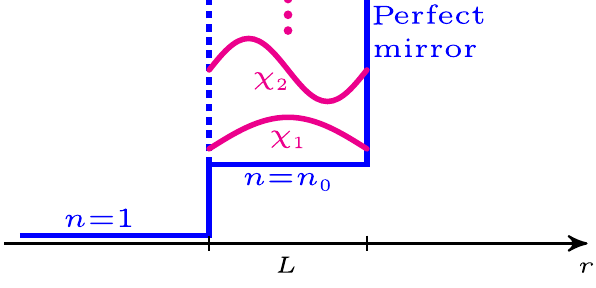
FIG. 14. A cavity geometry whose Schrödinger analog is solved exactly by Domcke [71] using the Feshbach projection